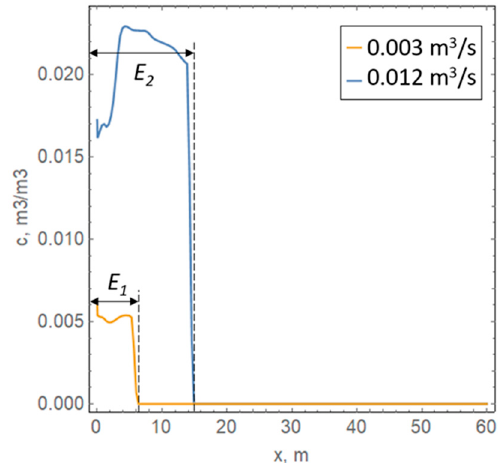
Figure 6. Methane concentration profiles along the line Y = 3.95 m for two different methane emission rates: 0.003 m 3 /s (orange curve, E 1 ) and 0.012 m 3 /s (blue curve, E 2 ).